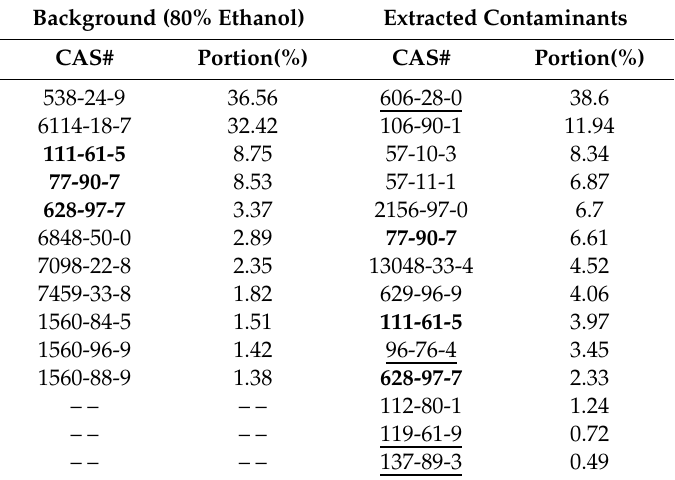
Table 1. GC-MS analysis of chemicals from ink circles on contaminated specimen collection devices extracted by 80% ethanol. Chemicals found in both samples were shown as bold typeface CAS numbers; chemicals with benzene ring in their structures were shown as underlined CAS